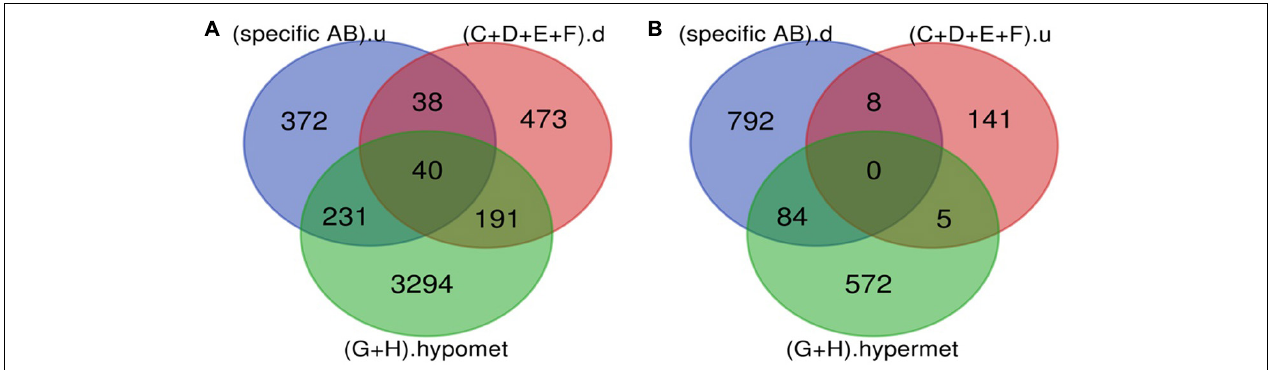
FIGURE 4 | Potential DR candidate genes. (A) Upregulated genes_Down-regulated miRNA targets_Hypomethylated genes: 40 up-regulated and hypomethylated genes were also the target of DR specific down-regulated miRNA. (B) Down-regulated genes_Up regulated miRNA targets_Hypermethylated genes: 0 down-regulated and hypermethylated were the target of DR specific up-regulated miRNA (specific AB).u: (up-regulated genes specific for DR); (C+D+E+F).d: (targets of DR specific down-regulated miRNA); (G+H).hypomet: (hypomethylated genes in NPDR and PDR); (specific AB).d: (down-regulated genes specific for DR); (C+D+E+F).u: (targets of DR specific up-regulated miRNA); (G+H).hypermet: (hypermethylated genes in NPDR and PDR).